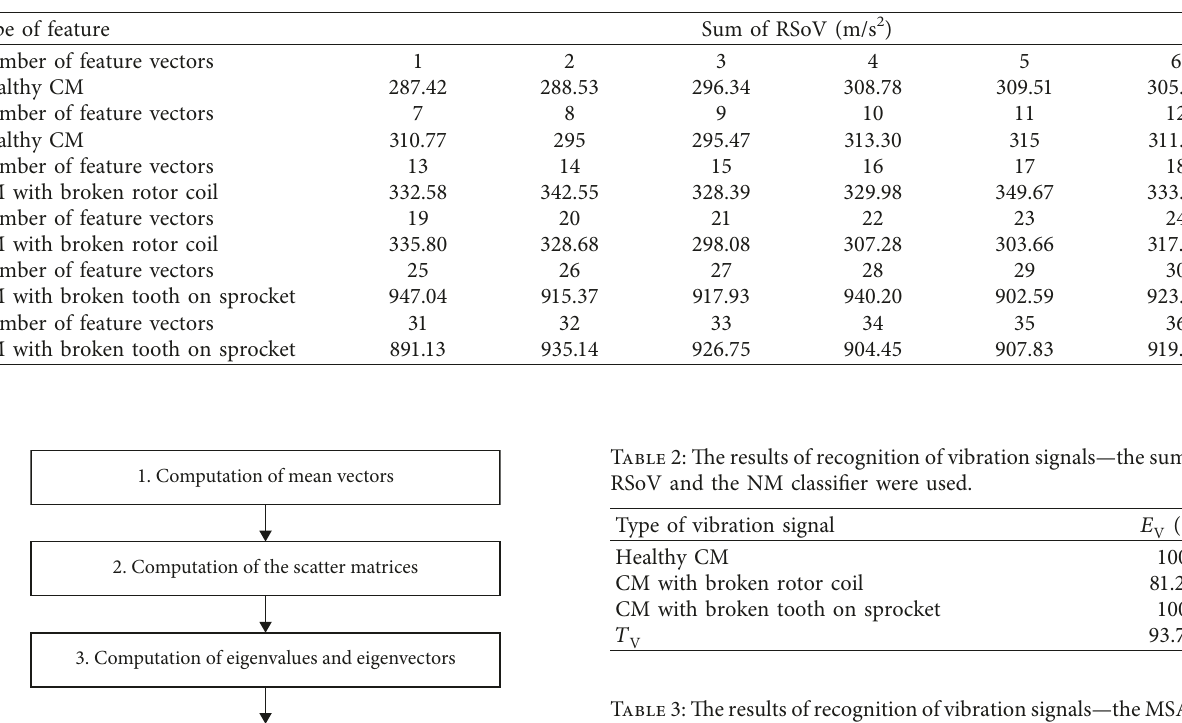
Table 1: Sum of RSoV for 36 (1-element) feature vectors of vibration data.